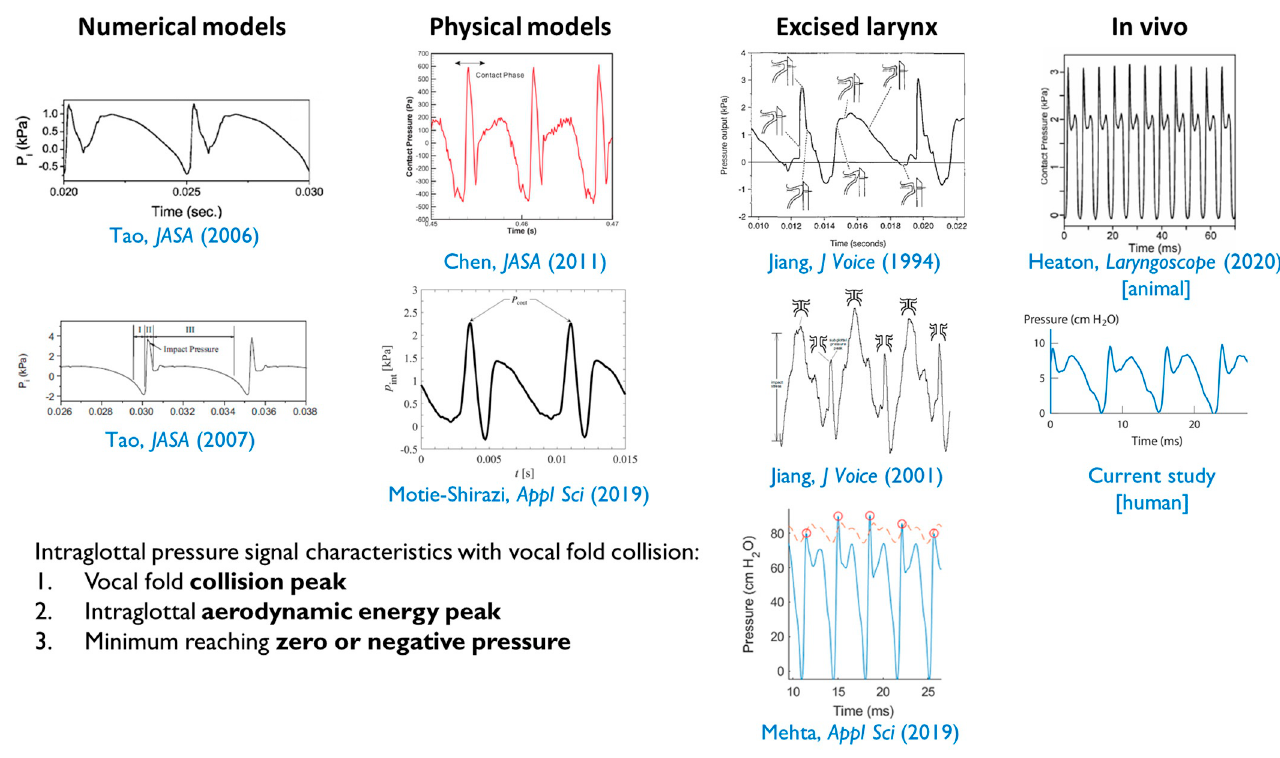
Figure 7. Comparison of the intraglottal pressure signal during phonation of the current study with exemplary intraglottal pressure signals observed in the literature according to numerical models [18,19], physical (synthetic material) models [12,14], excised larynx studies [13,22,25], and an in vivo animal study [29]. Figures reused with permission.